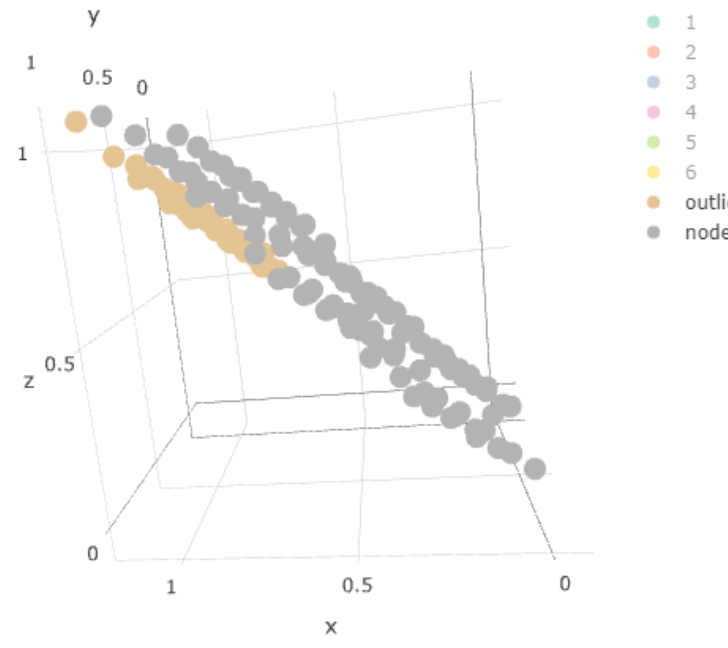
Figure 9. Weights over outlier